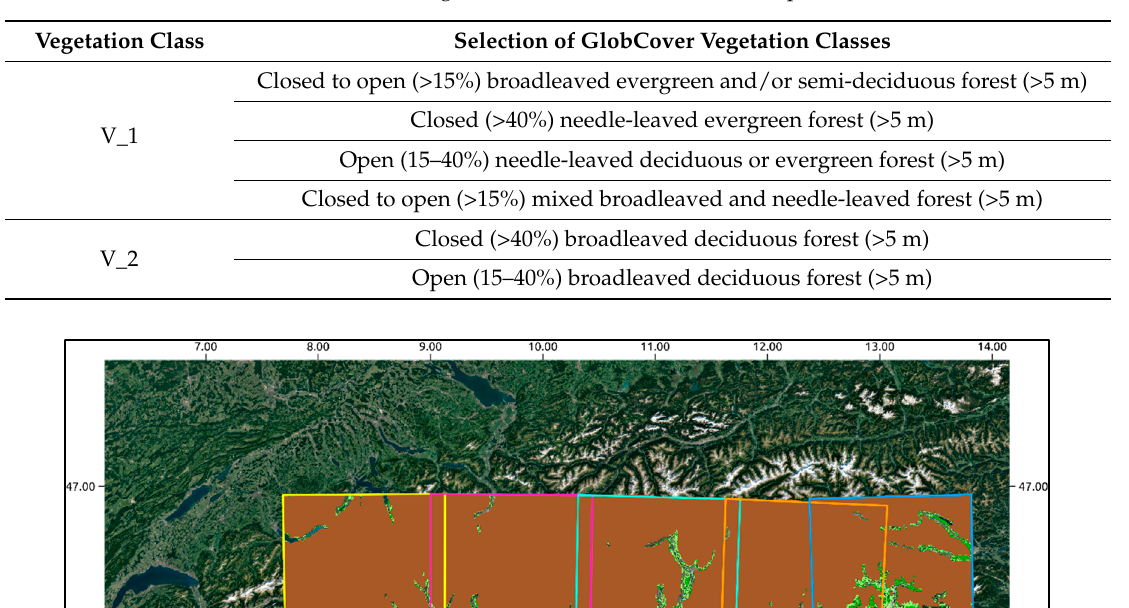
Table 2. Selected vegetation classes of ESA GlobCover product.